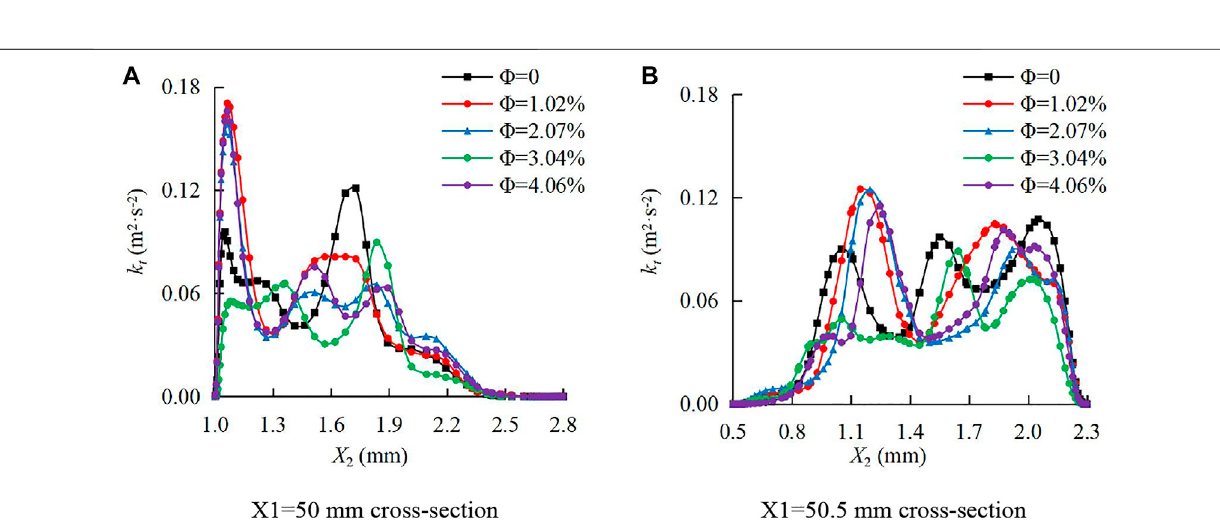
Frontiers in Physics |